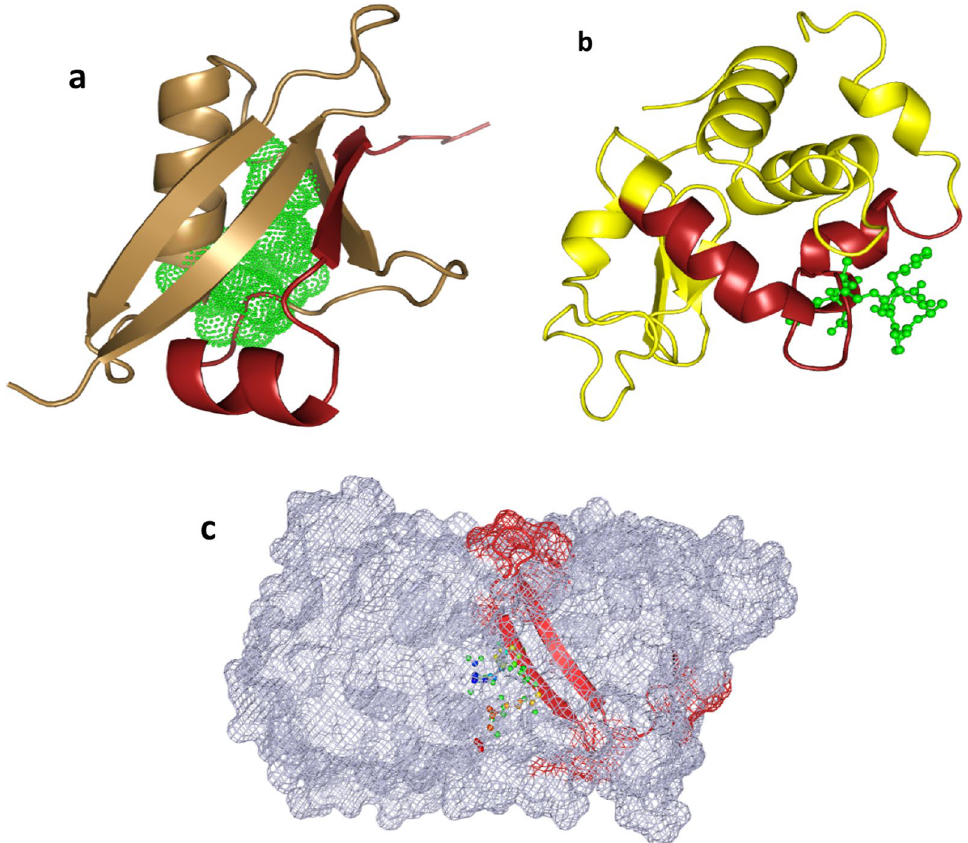
Fig. 5 Three-dimensional structures of HEESMP (visualization using PyMOL v2.4) a Homology modeled structure of UFM-1, showing the A-cell epitope (IM peptide) in brick red. The interacting structure depicted in the green mesh is the vaccine (HBsAg) peptide (5YAX_c). b) Homology modeled structure of Lysozyme C, also showing the A-cell epitope in brick red and the green stick and ball structure is the interacting vaccine peptide (5YAX_c). c PDB structure of ovalbumin (1OVA_a) showing the A cell epitope in brick red embedded in the structure represented as a